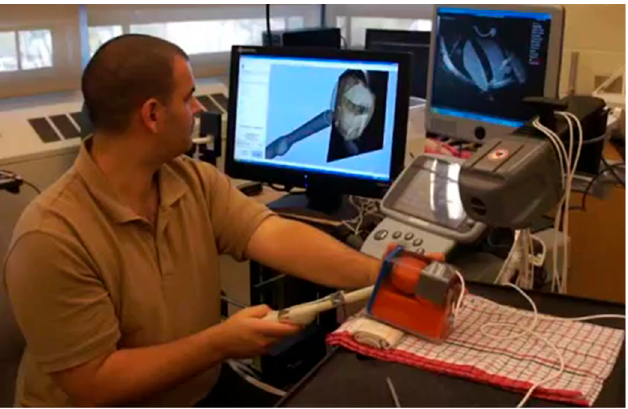
Figure 3. Preliminary prototype of the NaviPBx prostate biopsy system in a phantom setup. NaviPBx guides the physician with real-time “labels” painted over the live 2D TRUS image, such as in Figure 4a, showing models of the TRUS transducer (grey), biopsy needle (magenta), prostate gland (yellow) and biopsy target locations (pink), that are overlaid on the live 2D TRUS image. The physician interfaces with NaviPBx through a lightweight user interface optimized to execute only the necessary workflow while hiding all other functions. The system records all intra-operative data (e.g., time-stamped ultrasound, tracker, video, audio, rendering scenes, user actions, and internal variables) for offline analysis and validation when the user interface is turned back on at full functionality.